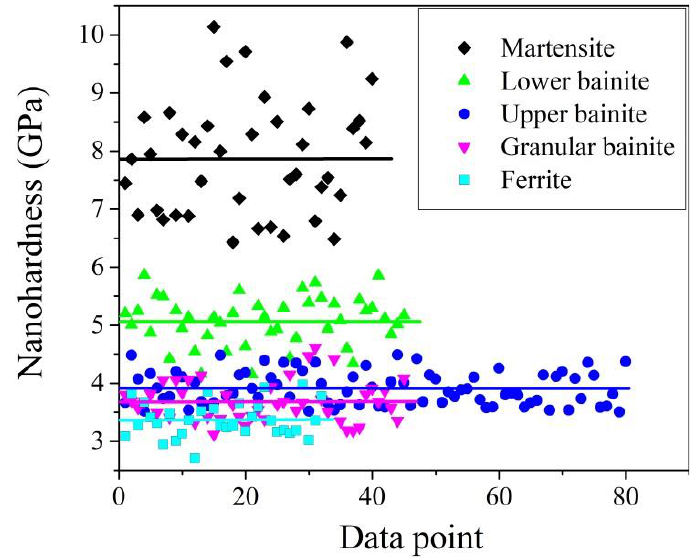
Figure 7. The nanohardness of different ferritic phases in low carbon steel (Fe-0.12C-1.0Si-2.0Mn in Figure 7. wt.%) [114].